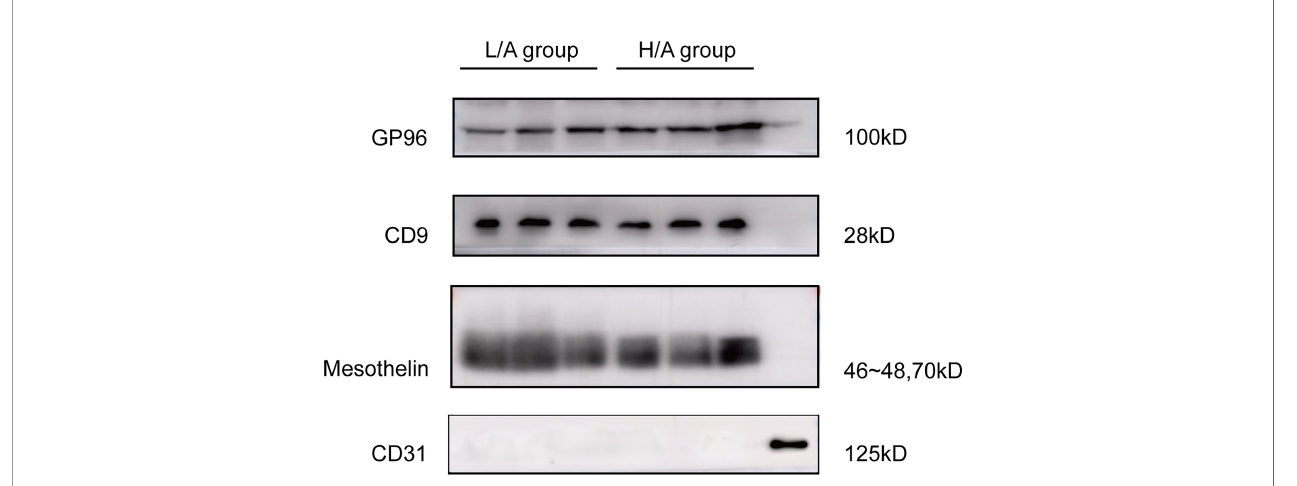
FIGURE 3 | Validation of the origin of PDE-EVs and expression of target protein in PDE-EVs. Detection of EVs target protein GP96, CD9 (EVs marker), mesothelin (mesothelial marker), and CD31(endothelial marker) in PDE-EVs isolated from the H/A group and the L/A group. A lysate of human omentum was used as positive control for CD31. 50 µg of total protein from each sample was added to each well for western blotting; n = 7. The results shown are from one representative of three independent